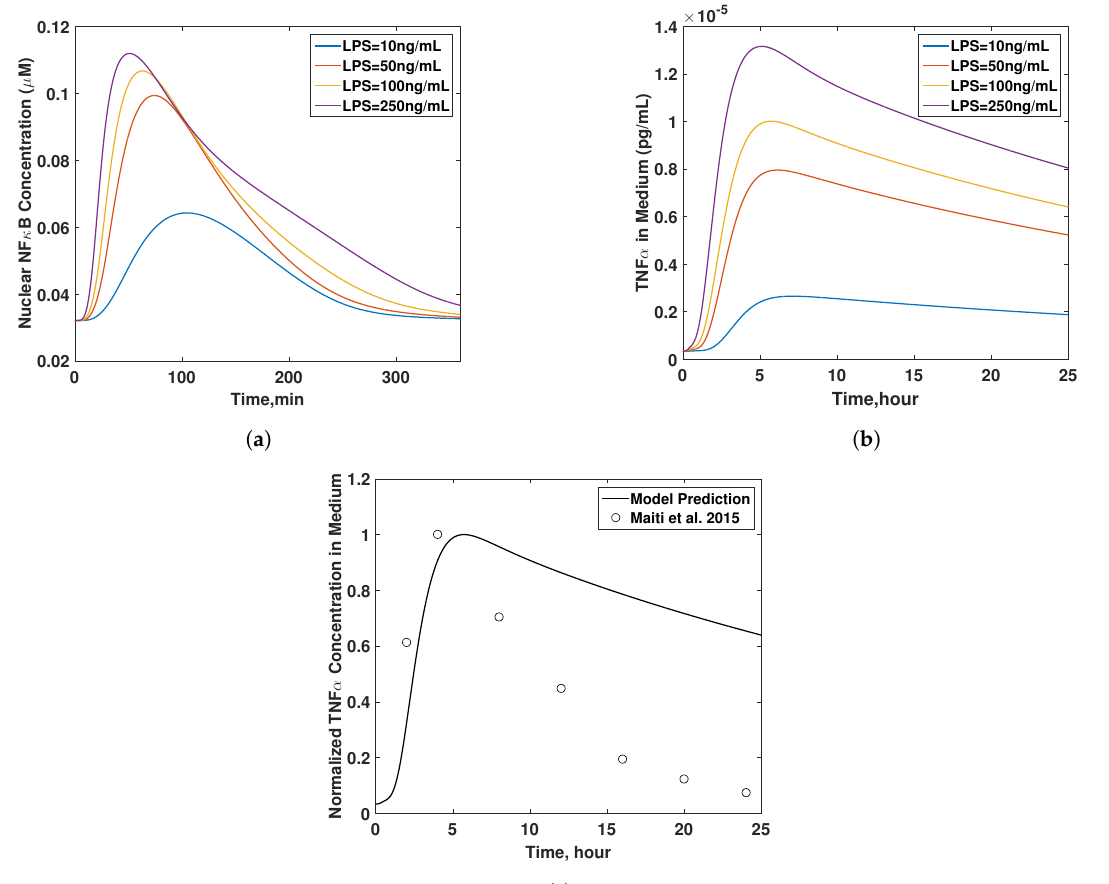
Figure 5. Simulated dynamics of NF κ B nuclear translation and TNF α secretion. ( a ) Nuclear NF κ B concentration and ( b ) the amount of TNF α secreted to the medium upon stimulation by 10, 50, 100 and 250 ng/mL of LPS. ( c ) The simulated dynamics of TNF α concentration in the medium was compared with the measurement by Maiti et al. [15] in response to 100 ng/mL of LPS. The TNF α concentration at each point was normalized to the maximum value